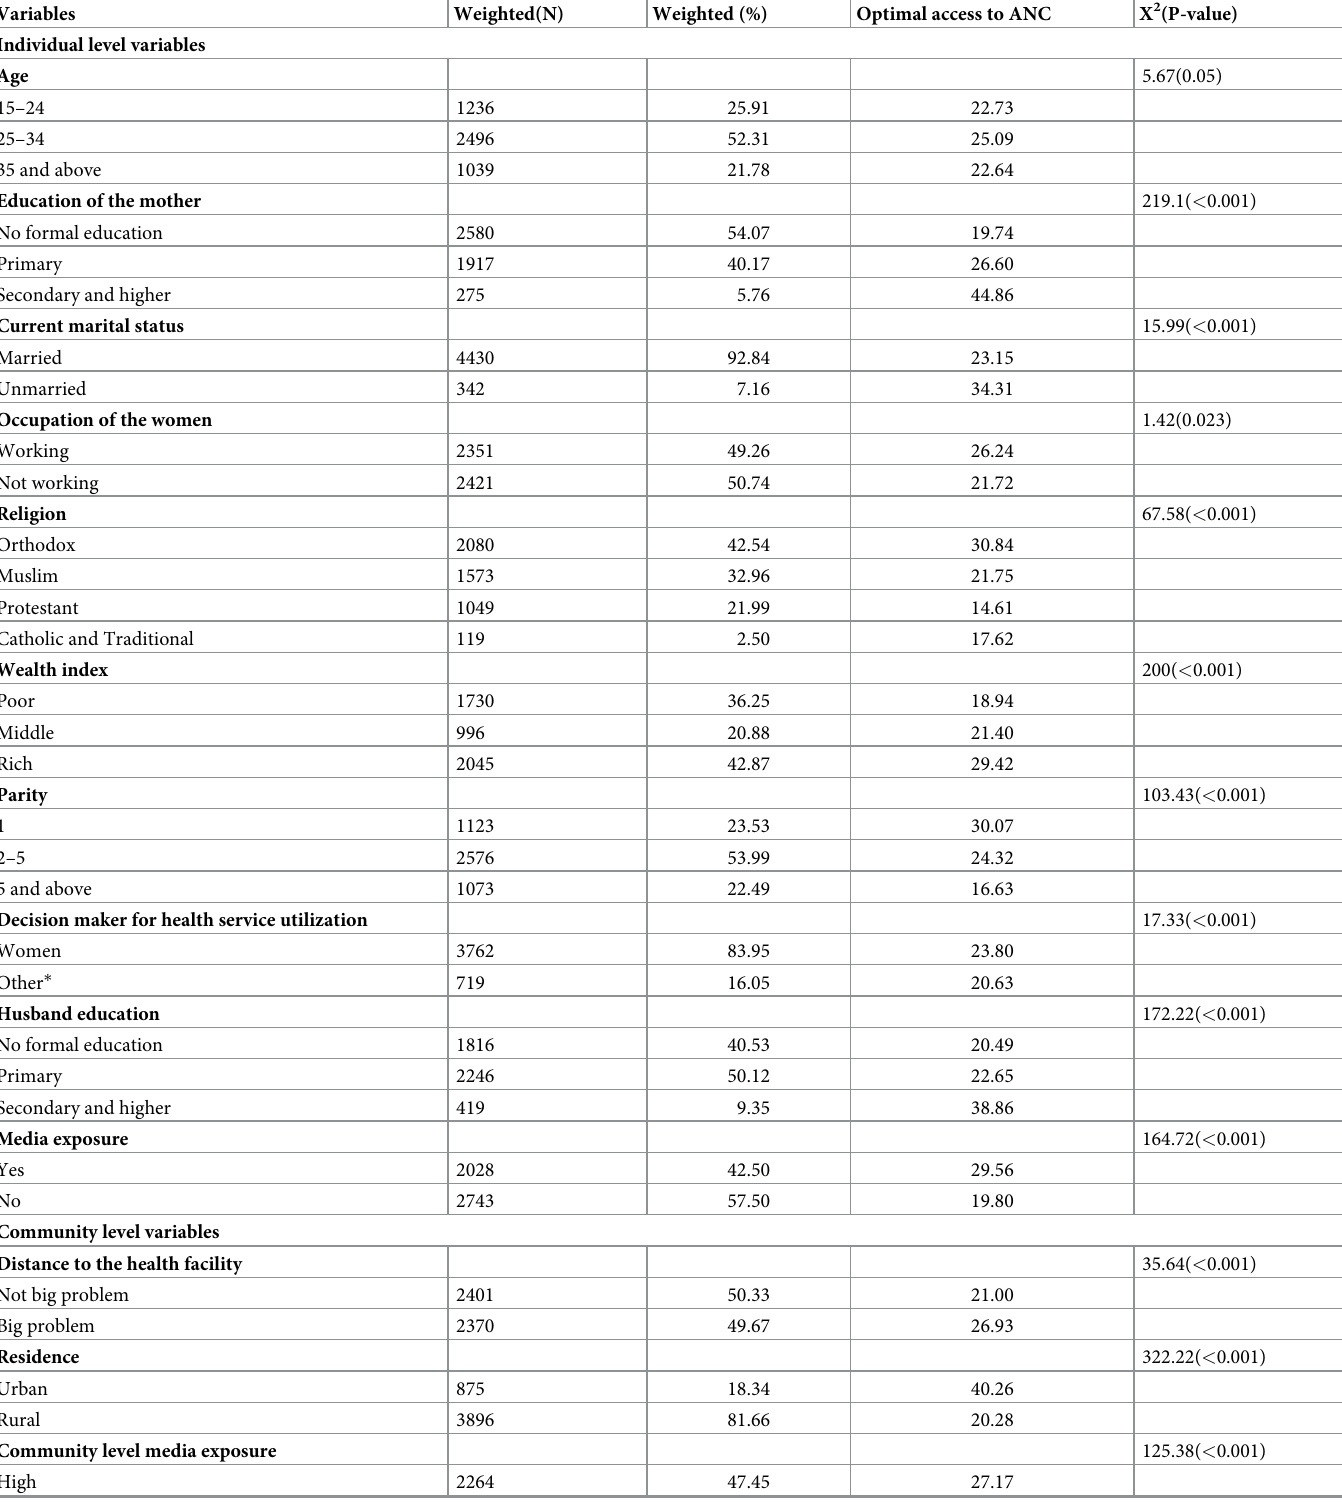
Table 1. Distribution of optimal access to ANC across individual and community level factors of pregnant women in Ethiopia, 2016 (n =